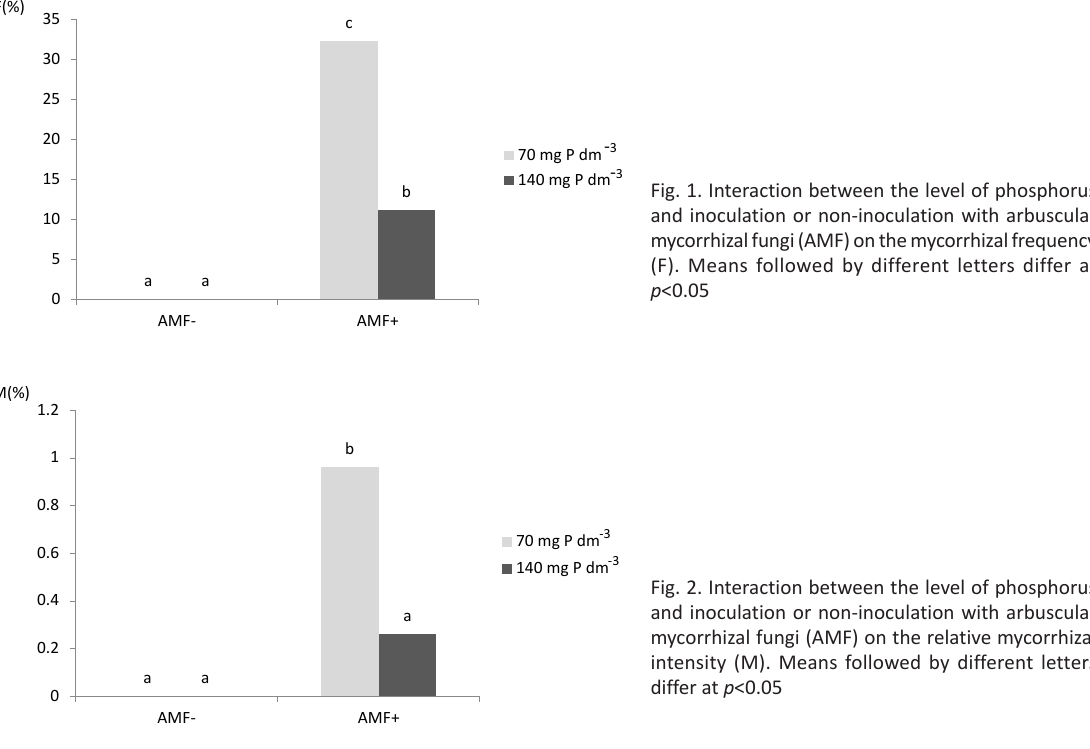
Fig. 1. Interaction between the level of phosphorus and inoculation or non-inoculation with arbuscular mycorrhizal fungi (AMF) on the mycorrhizal frequency (F). Means followed by different letters differ at p <0.05